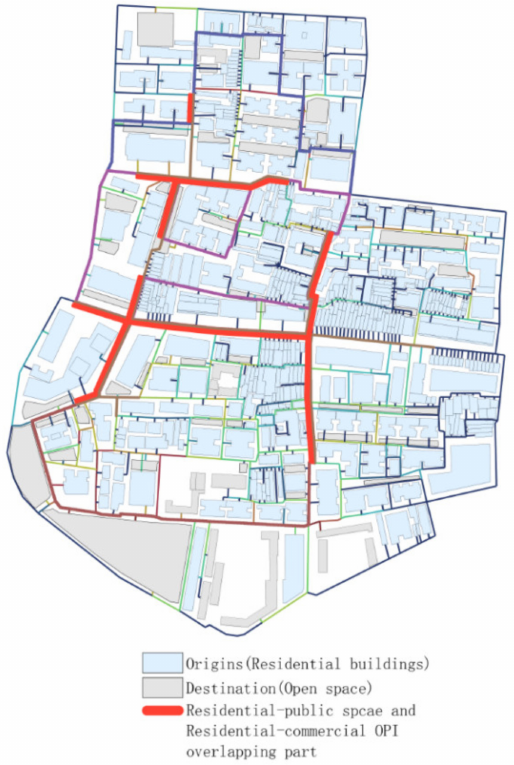
Figure 10. Distribution map of overlapping crowed routes from residential buildings to public activity area and to commercial